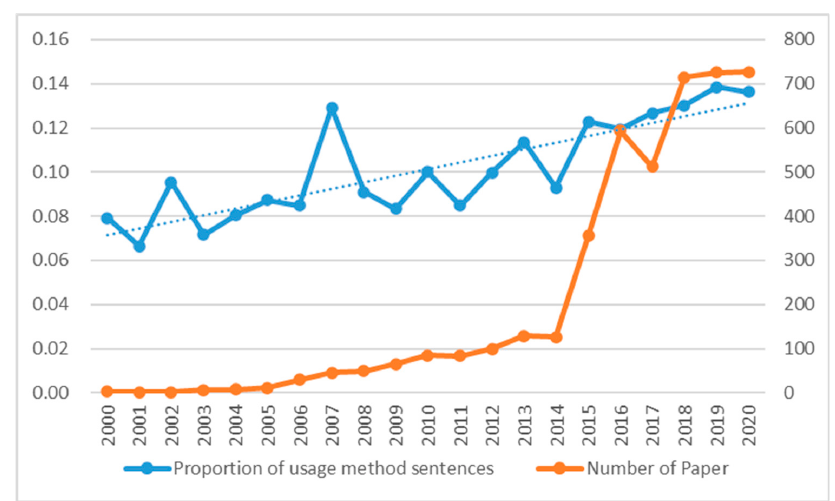
Figure 5. Yearly distribution of usage method sentences in papers.